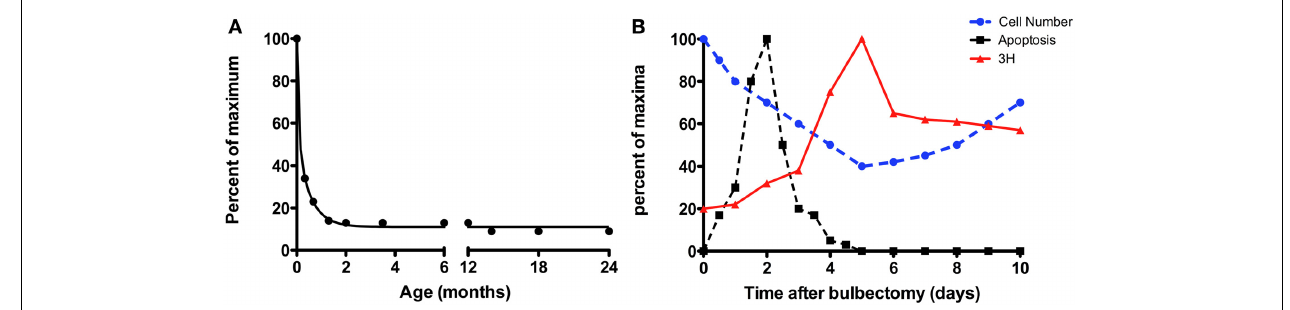
FIGURE 2 | The effect of organismal age on the rate of neurogenesis. (A) The number of cells incorporating BrdU per mm in the rodent declines precipitously over the first month of life, but reaches a steady-state level in the adult that does not appear to be profoundly affected by aging. Graph of the authors’ calculations from Wilson and Raisman (1980); Weiler et al. (1999); Weiler (2005); Brann and Firestein (2010), normalized to peak value reported. (B) The